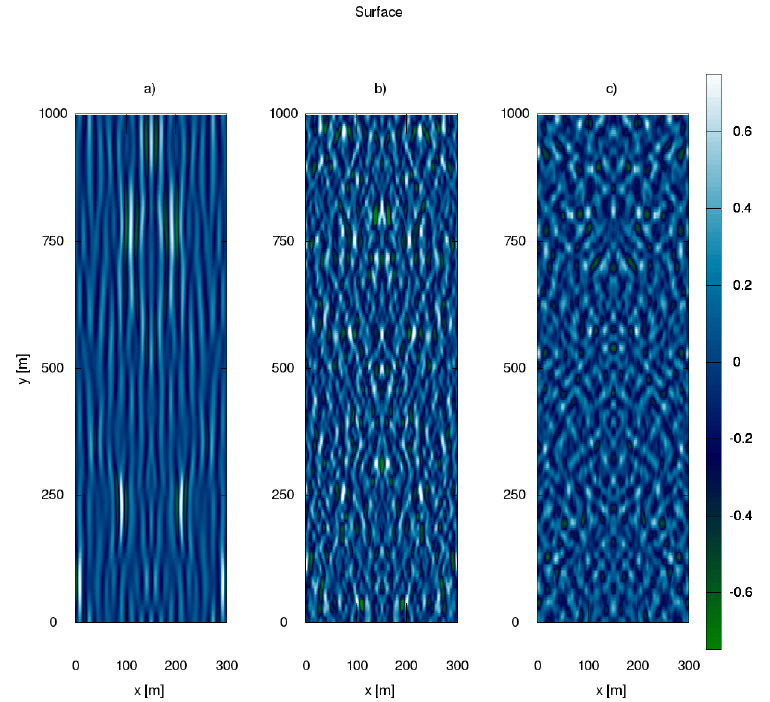
Figure 7. The evolution of surface η ( x , y , t ) in time. The color shows the amplitude of the waves in meters. Panel ( a ) corresponds to the almost initial surface at time t ≈ 2 min. Panel ( b ) corresponds to the surface at time t ≈ 1 h, and Panel ( c ) corresponds to the surface at time t ≈ 26